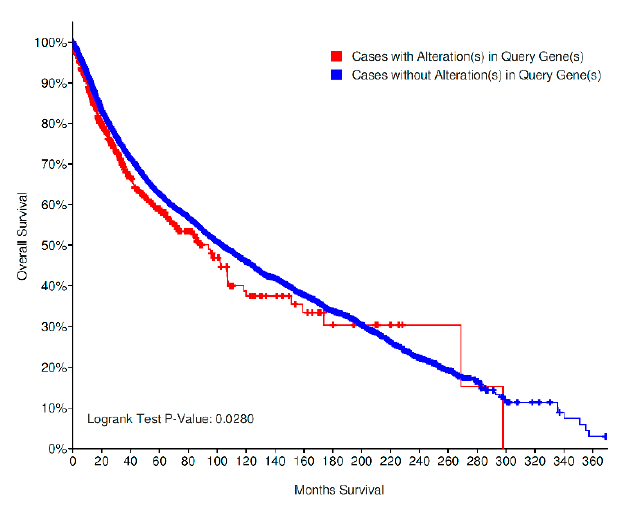
Figure 4. Overall survival of LRRK2 altered (MUT and / or CNV) vs. LRRK2 non-altered cases. A slightly worse prognosis can be observed for altered cases [48–50]. MUT: point mutations, indels and fusions; CNV: copy-number variations.